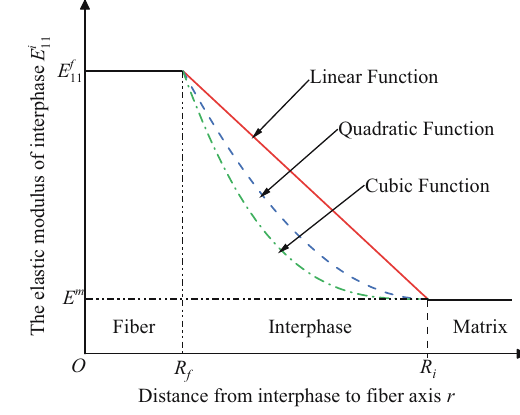
Figure 12: The variation of composite elastic property with di ff erent interphase types when the interphase thickness increases from 0.1 to 0.5 μ m.